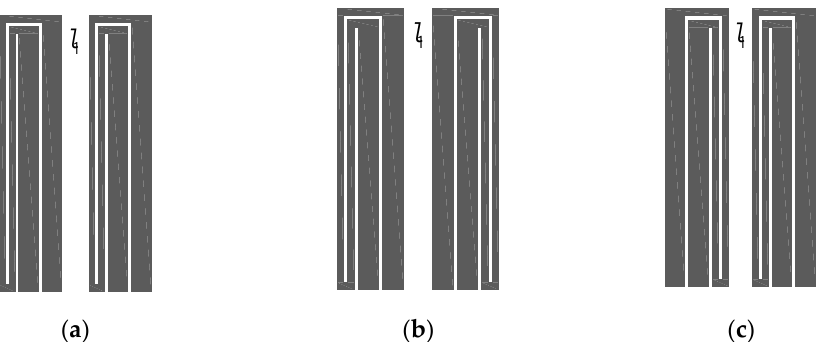
Figure 4. Coupling structure between the resonators of type I. ( a ) In order; ( b ) face to face; ( c ) back to back.